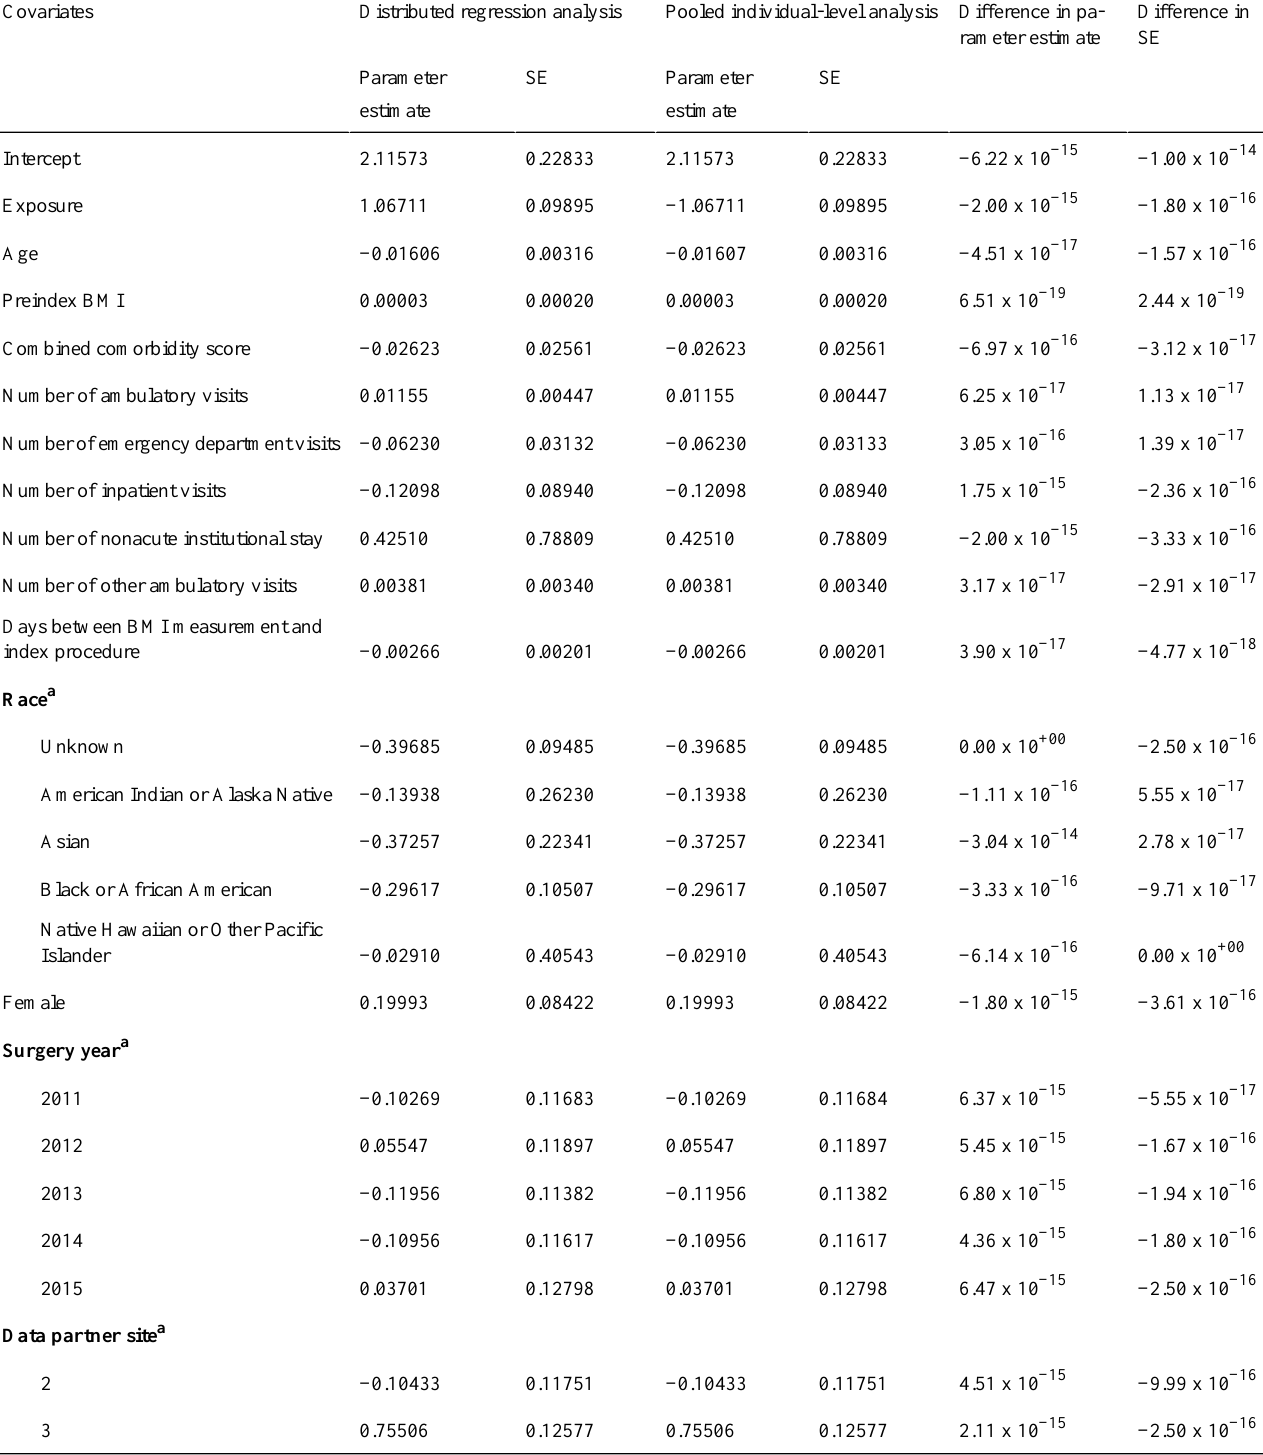
Table 3. Distributed logistic regression vs pooled individual-level logistic regression.